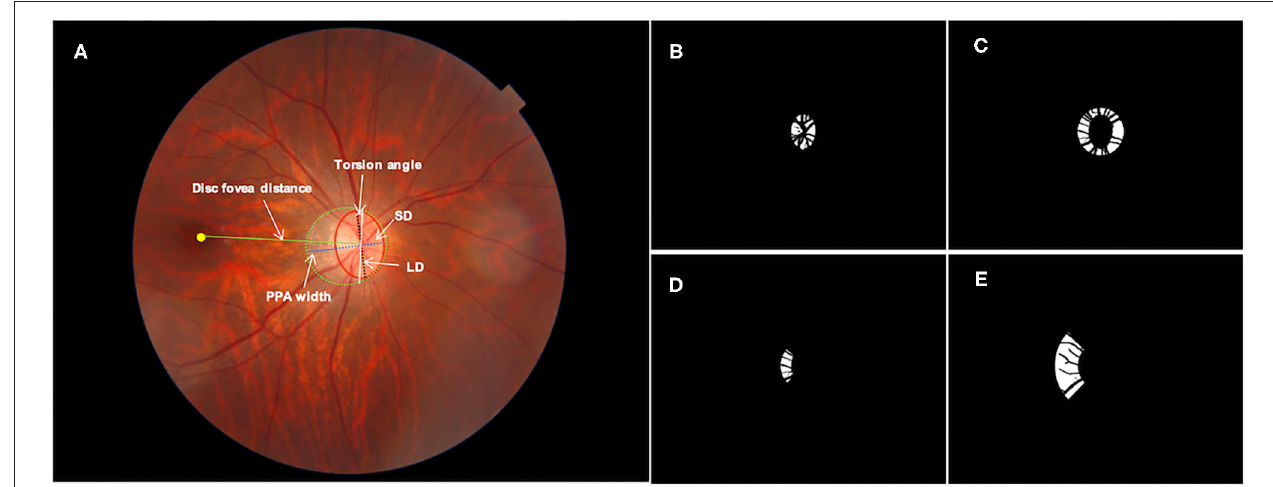
FIGURE 1 | Definition of regions of interest for imaging feature extraction: (A) original fundus photograph. The optic disc (red solid line), peripapillary atrophy (PPA, green dotted line) and macular fovea (yellow dot) were annotated manually. The white arrows indicate PPA width (blue solid line), disc fovea distance (green solid line), the longest diameter (LD, black dotted line) and shortest diameter (SD, blue dotted line) of the optic disc. The ovality index was defined as the ratio between the LD and SD of the optic disc. Torsion angle was measured between the LD and the vertical line (white solid line) 90 ◦ from the line connecting the fovea and the center of the optic disc. (B) Mask of optic disc; (C) mask of the inner ring; (D) mask of the inner temporal region and (E) mask of the outer temporal region. Vessels were excluded for imaging feature extracting.